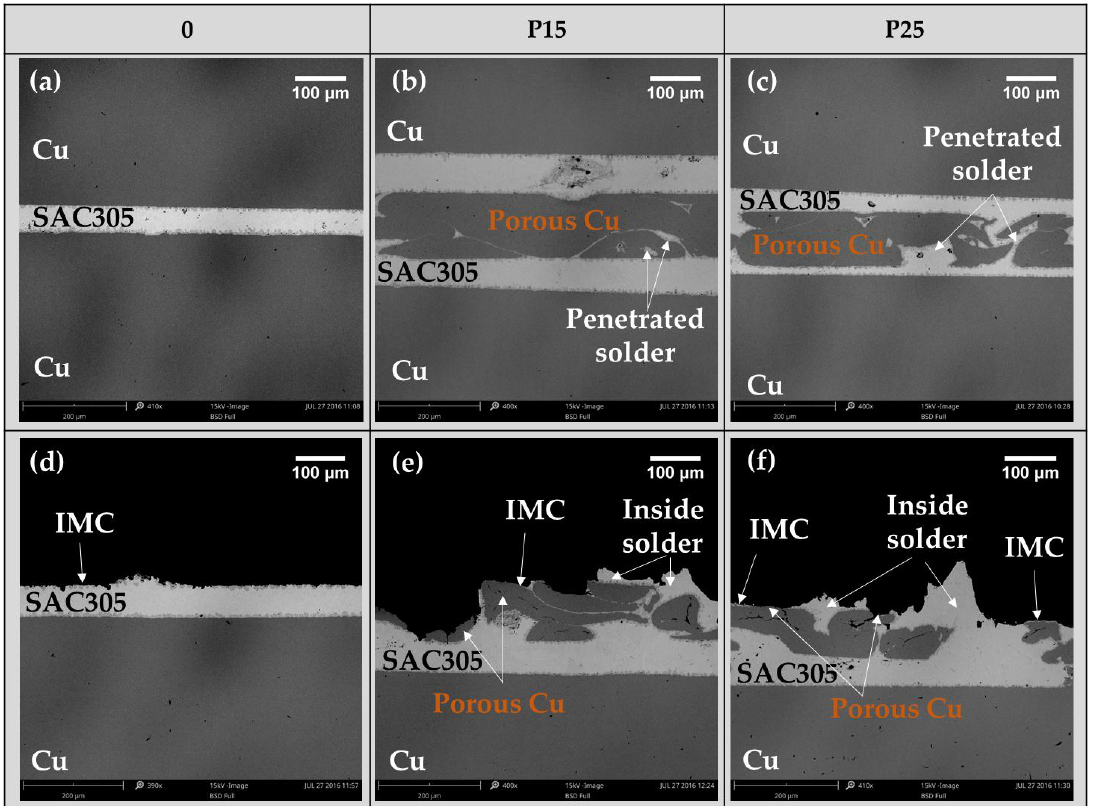
Figure 10. Cross-sectional image of solder joint at soldering temperature of 307 °C with soldering time of 300 s, ( a – c ) as-soldered cross section; and ( d – f ) after crack; for solder joint with 0, P15, and P25 porous Cu.